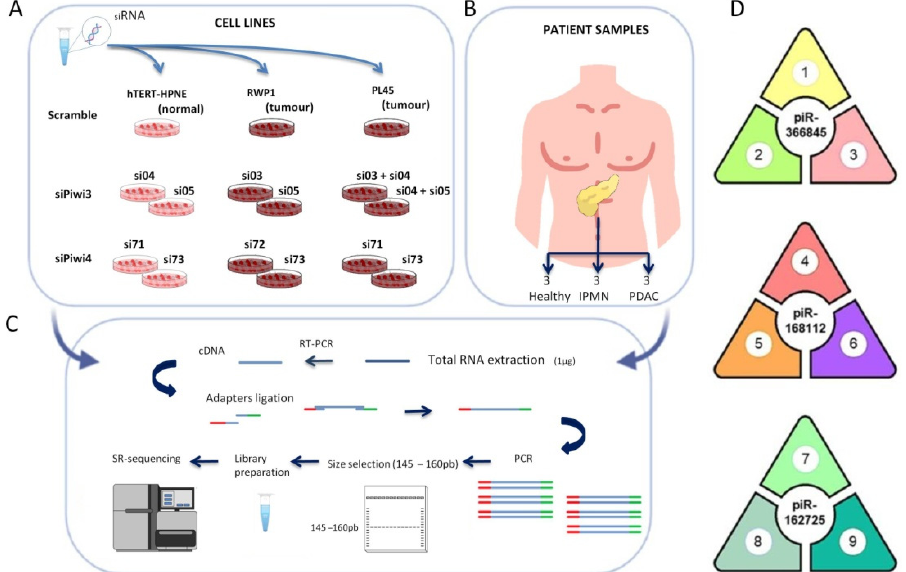
Figure 1. Small RNA sequencing of modified human pancreatic cancer and normal cell lines and hu- man pancreatic tissues revealed three differentially expressed piRNAs. ( A ) Schematic representation of the procedure for PIWIL3 or PIWIL4 downregulation. Here, two pancreatic tumour cell lines and one non-tumour cell line were transfected with two independent siRNA sequences to downregulate PIWIL3 or PIWIL4. As a control, all cell lines were transfected with a scramble siRNA. ( B ) RNA from fresh-frozen human tissues obtained from pancreatic ductal adenocarcinomas (n = 3), intraductal papillary mucinous neoplasms (n = 3), and healthy pancreatic tissues (n = 3) were included in the NGS of small RNA. ( C ) cDNA was obtained from the total RNA isolated from all samples. After adapter ligation by PCR, the fragments were loaded onto a polyacrylamide gel, and bands from 145–160 bp were excised and purified to continue with small RNA library preparation. Sequencing was performed on a MiniSeq Platform (Illumina). ( D ) Three different piRNAs were commonly found in three different data integrations: 1: healthy pancreas tissues vs. PL45 and RWP1 scramble; 2: hTERT-HPNE scramble vs. PL45 and RWP1 scramble; 3: hTERT-HPNE downregulated for PIWIL4 vs. hTERT-HPNE scramble; 4: RWP1 and PL45 downregulated for PIWIL3 vs. hTERT-HPNE down- regulated for PIWIL3; 5: RWP1 and PL45 downregulated for PIWIL3 vs. PDAC and intraductal papillary mucinous neoplasm (IPMN) pancreatic samples; 6: RWP1 and PL45 downregulated for PIWIL3 vs. RWP1 and PL45 scramble; 7: RWP1 and PL45 scramble vs. IPMN pancreatic samples; 8: RWP1 and PL45 scramble vs. hTERT-HPNE scramble; 9: RWP1 downregulated for PIWIL3 vs. RWP1 downregulated for PIWIL4; NGS: Next Generation